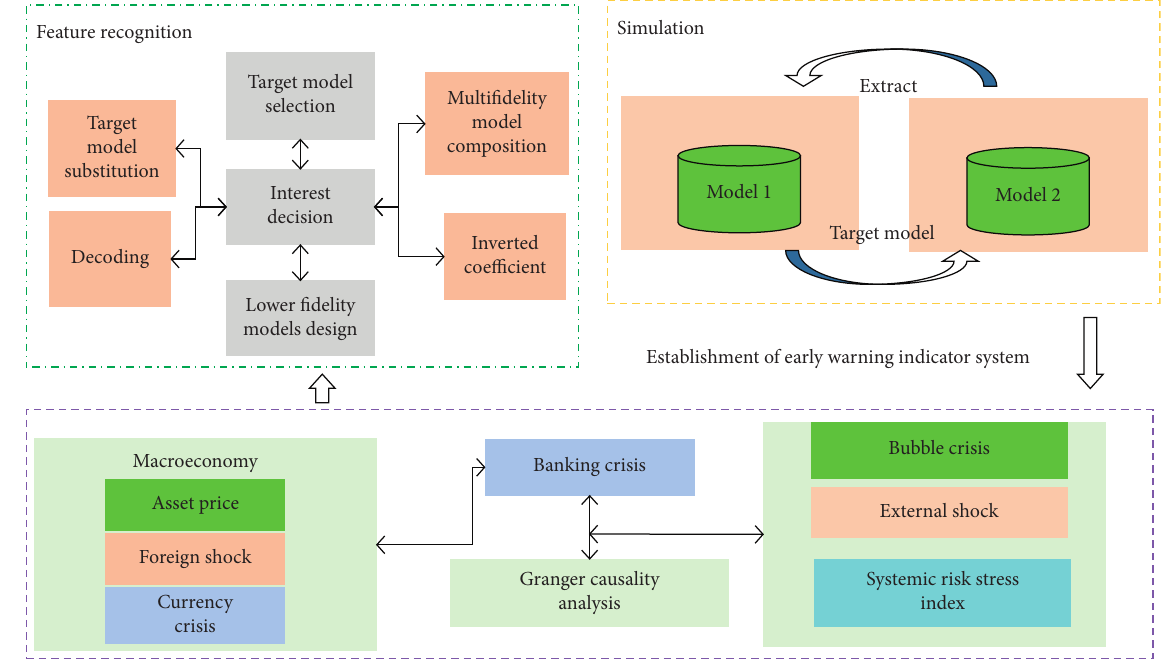
Figure 1: The discrete selection